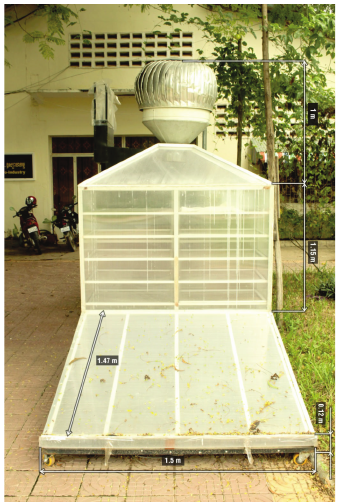
Figure 1: The schematic picture of natural convection solar